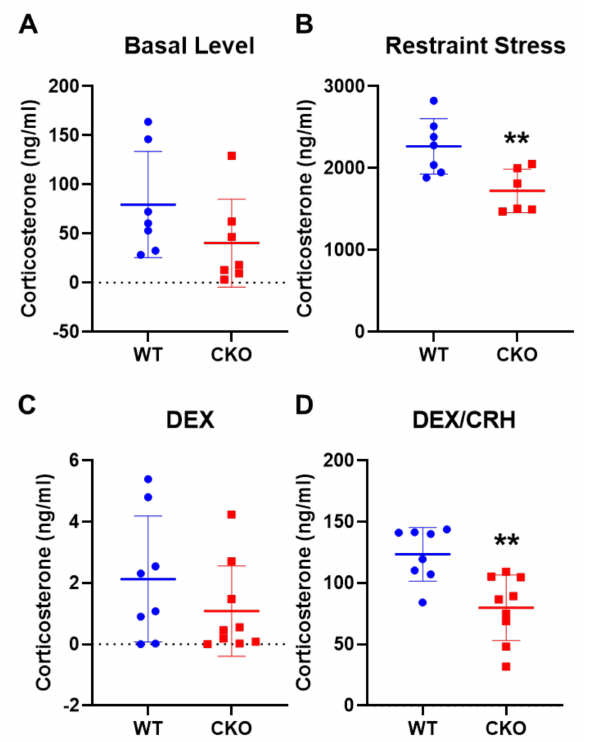
Figure 2. CKO mice have reduced corticosterone levels after restraint stress and in DEX/CRH testing. ( A , B ) Corticosterone concentration in basal ( A ) and restraint stressed conditions ( B ) in WT ( n = 7) and CKO ( n = 7) mice. ( C , D ) DEX/CRH test. The corticosterone level after DEX treatment ( C ) and then CRH challenge ( D ) in WT ( n = 13) and CKO ( n = 14) mice. Results are presented as means ± SD, ** p ≤ 0.01, compared with the WT